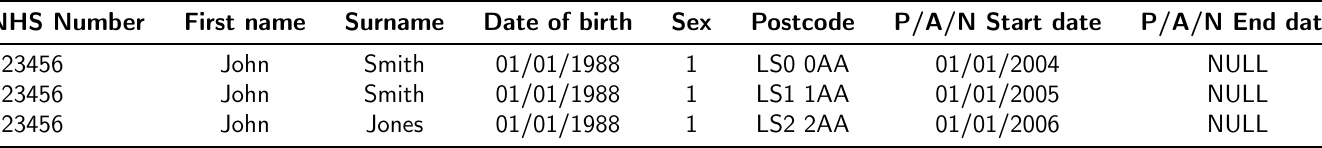
Supplementary Table 3: Example of PDS linkage